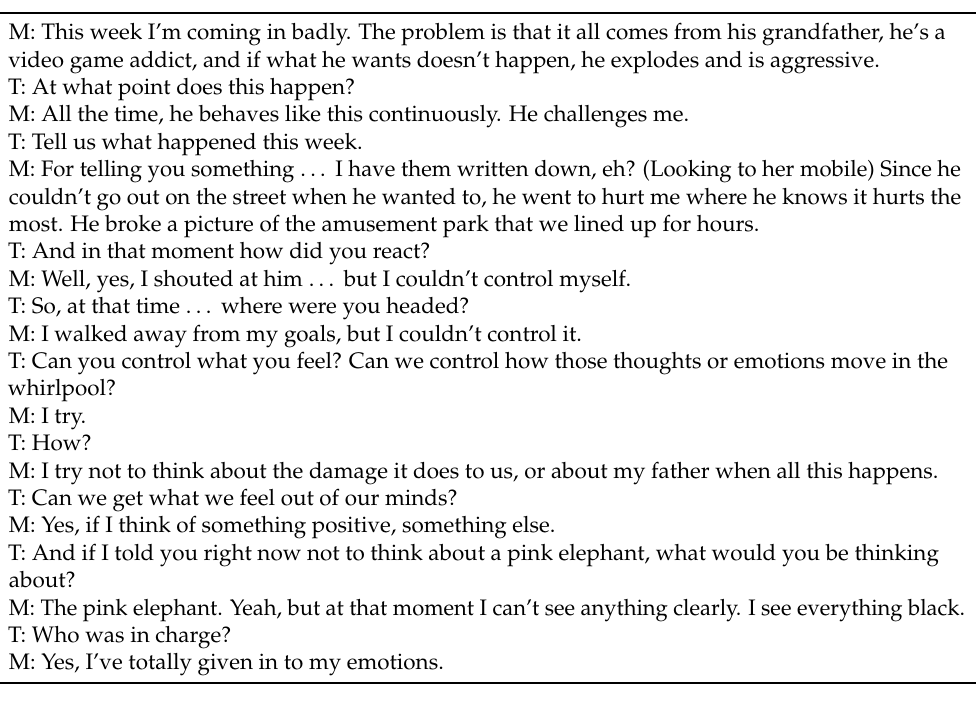
Table A1. Example of a clinical protocol dialogue with the